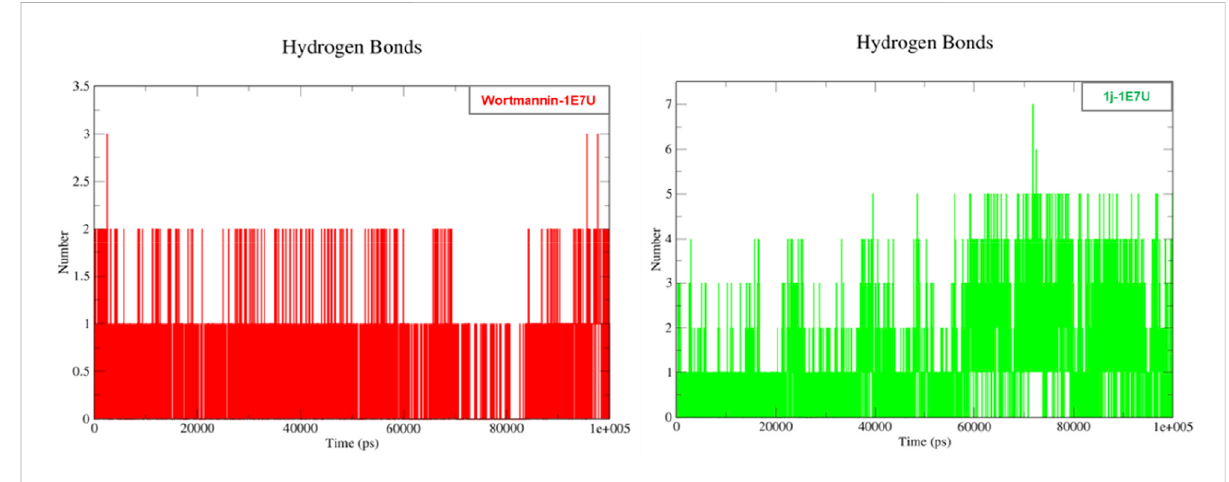
FIGURE 9 Hydrogen bond analysis throughout the 100 ns - 1E7U with Wortmannin (red), 1E7U with 1j (green).